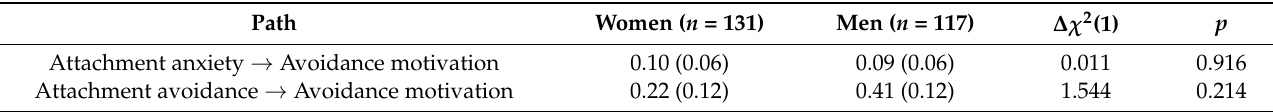
Table 4. Multigroup analyses on gender invariance of structural